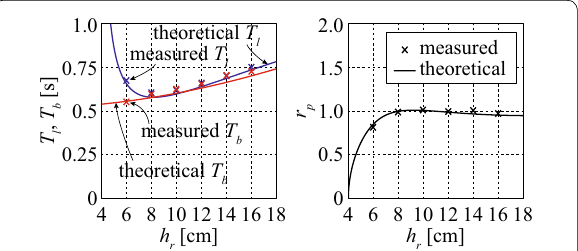
Fig. 11 T‑shaped bimetal sheet Fig. 12 Theoretical and measured periods, and their